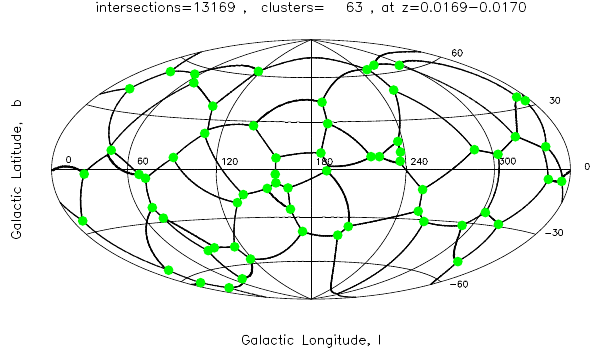
Figure 5. The Voronoi-diagram V P , s (2, 3) in the Hammer–Aitoff